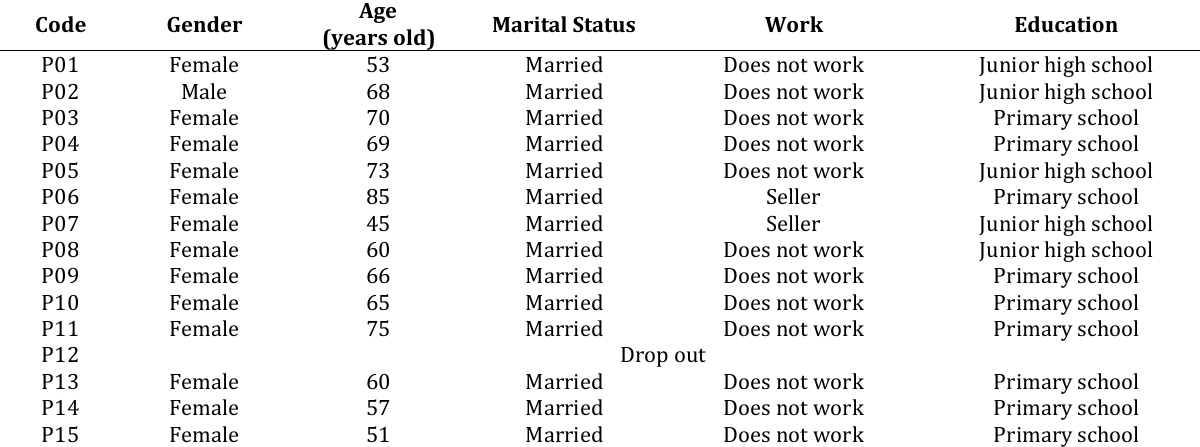
Table 1. Characteristic of Respondents